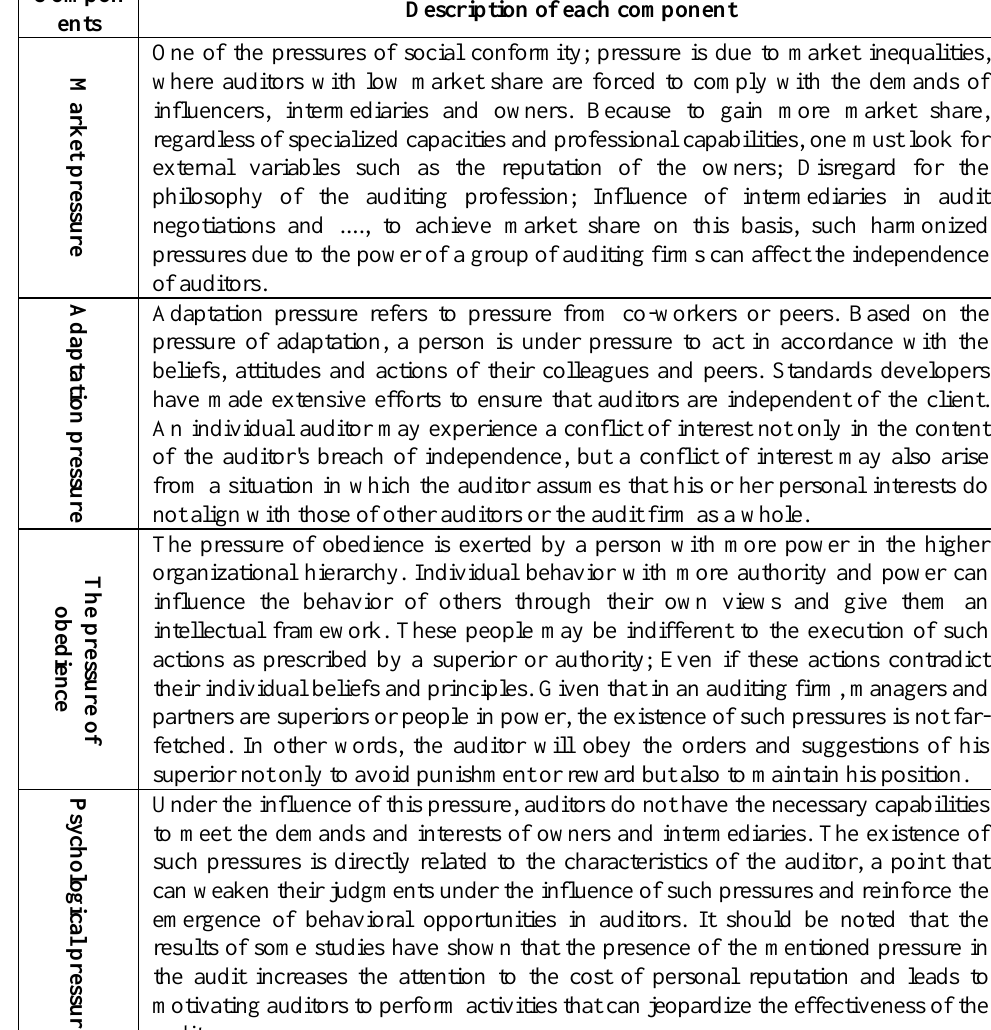
Table 3. Supply Chain Flexibility